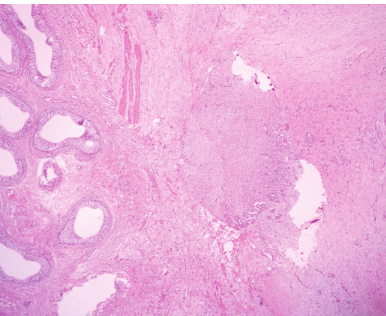
Figure 3: Calretinin immunohistochemistry highlighting the mus- cle infiltrative properties of the neoplastic mesothelial cells in deep submesothelial lamina propria ( × 400 magnification; H&E